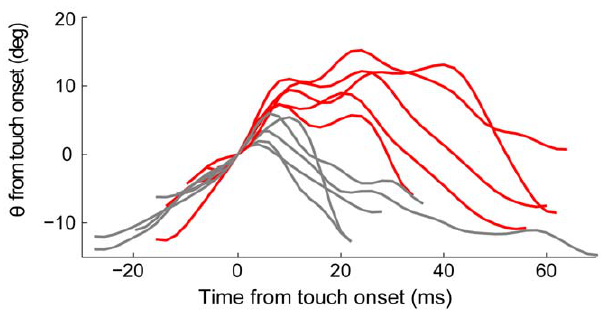
Figure 2. Whisking and head motion in freely moving rats. Examples of whisker trajectories (filtered at 80 Hz) from freely-moving rats performing a localization task [6], demonstrating the occurrence of whisks with a single peak (gray) and multiple peaks (red) after contact onset.